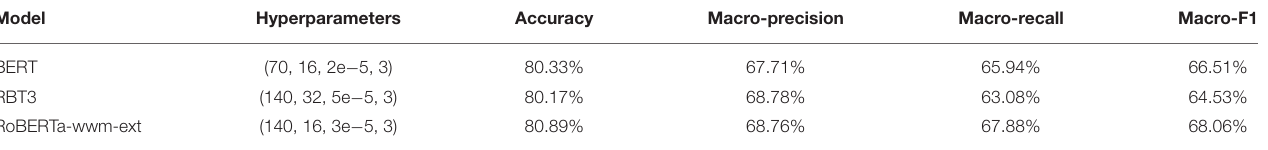
TABLE 4 | Results of stance